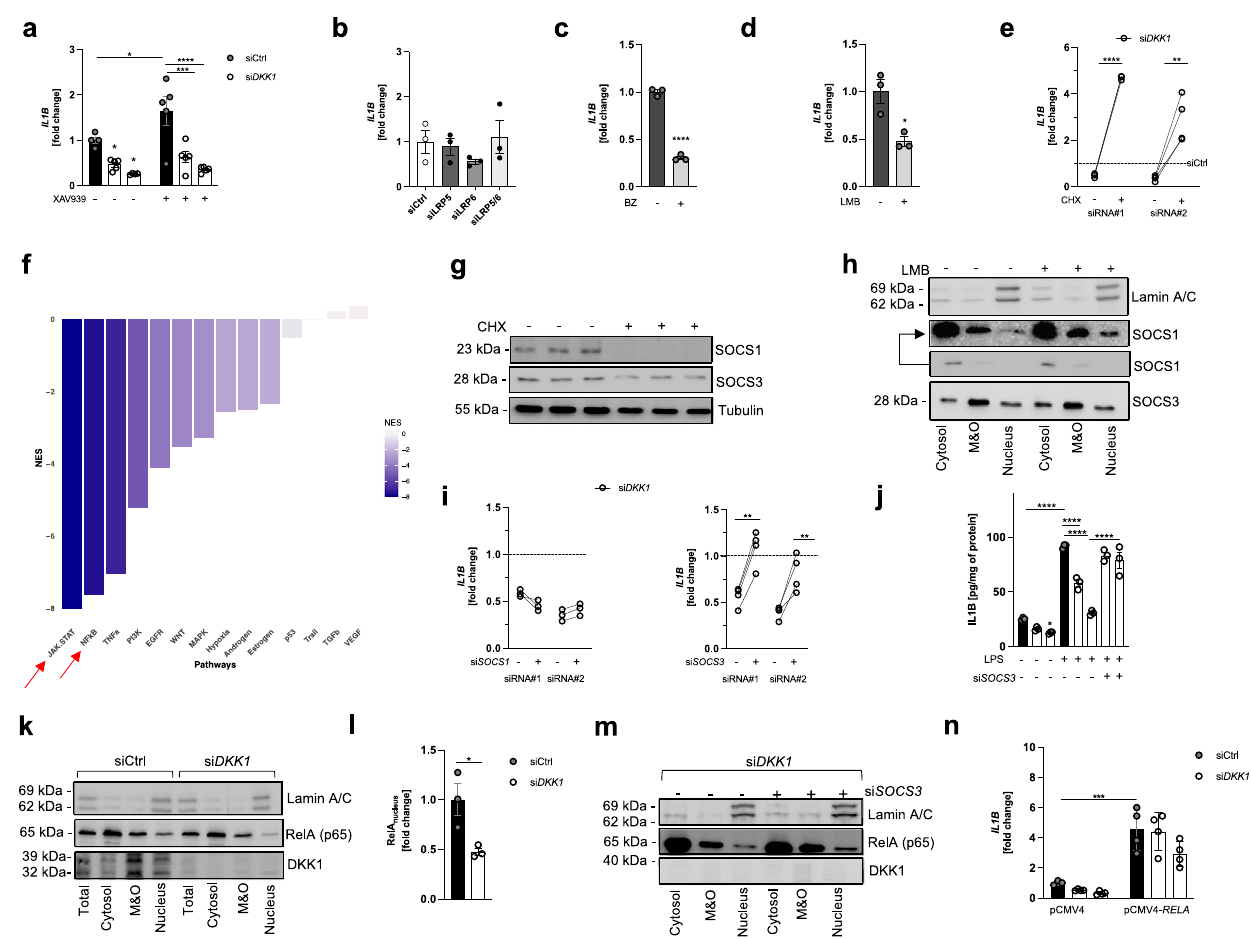
Circulating DKK1 levels during the acute, initial phase of pneumonia (day 1 or 2 of hospitalization) were characterized by considerable interindividual variability (range: 1.13 – 48.05 pmol/l) (Fig. S5b). DKK1 serum concentration increased modestly across the disease trajectory ( + 22%), which coincided with reductions in C-reactive protein levels (CRP), white blood cell count (WBC) body temperature (fever) as well as increases in circulating platelet numbers, markers of clinical recovery (Fig. S5c –